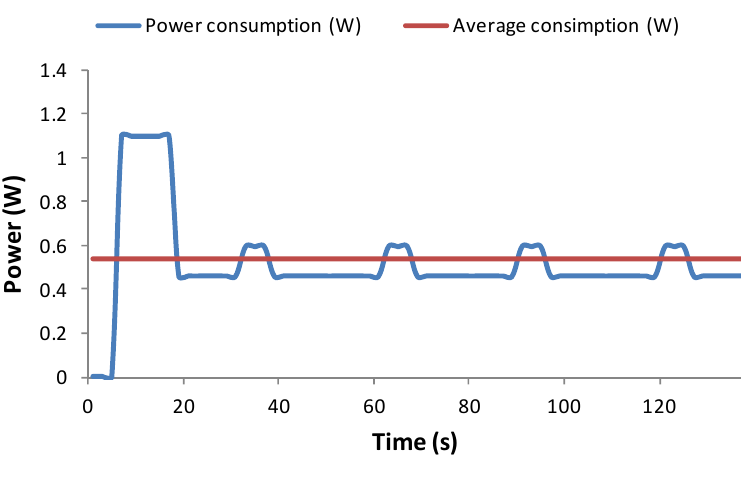
Figure 6. Underwater wireless sensor node